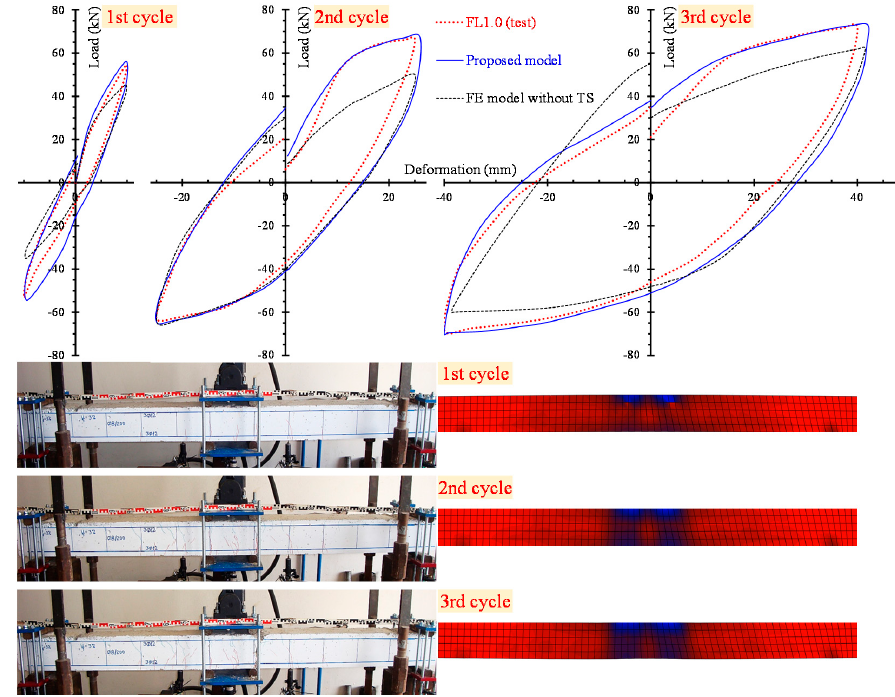
Figure 9. Comparisons between analytical and experimental results of slender beam FL1.0 in load versus deformation curves and cracking patterns for the 1st, 2nd and 3rd loading cycle. Materials 2020 , 13 , 2923